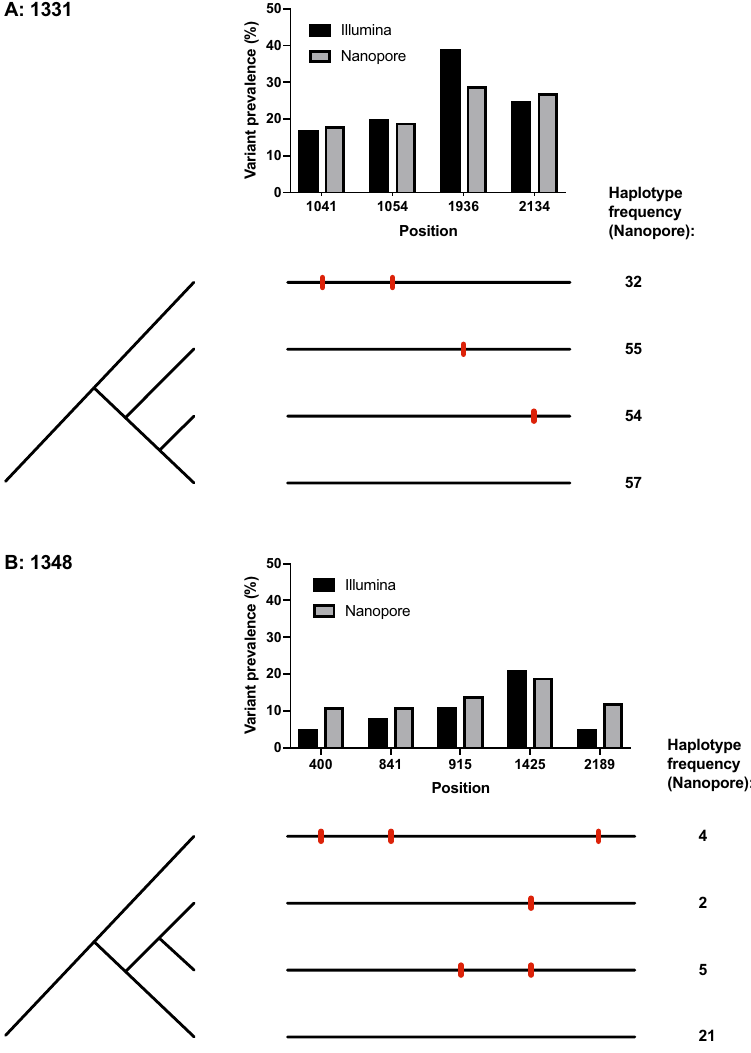
Figure 6. Maximum parsimony trees showing haplotypes called using corrected Nanopore concatemers. For each of samples 1331 and 1348, the high quality variant calls (as listed in Suppl Table 3) were used as a definitive set of variant sites. For each corrected concatemer, the haplotype was called according to the corrected bases at these variant sites. Haplotypes that occurred at > 1% frequency within the sample are shown here, with the additional exclusion of one haplotype in sample 1331 that occurred at much lower frequency than those shown (only 3 occurrences) and did not allow for construction of a maximum parsimony tree without homoplasy. Counts of haplotypes are recorded on the left hand side, while the frequency of the variants in the Illumina and Nanopore data is indicated in bar charts along the top of each diagram. Variants (bases differing from the consensus) are indicated with a red bar on the horizontal lines that represent the whole-genome haplotypes. A potential method for assigning quality scores to haplotype calls, based on the length and number of the concatemers supporting the call, is presented in Suppl Methods 3. Based on these calculations, all haplotypes with ≥ 3 concatemers supporting them have a phred-based quality score of >